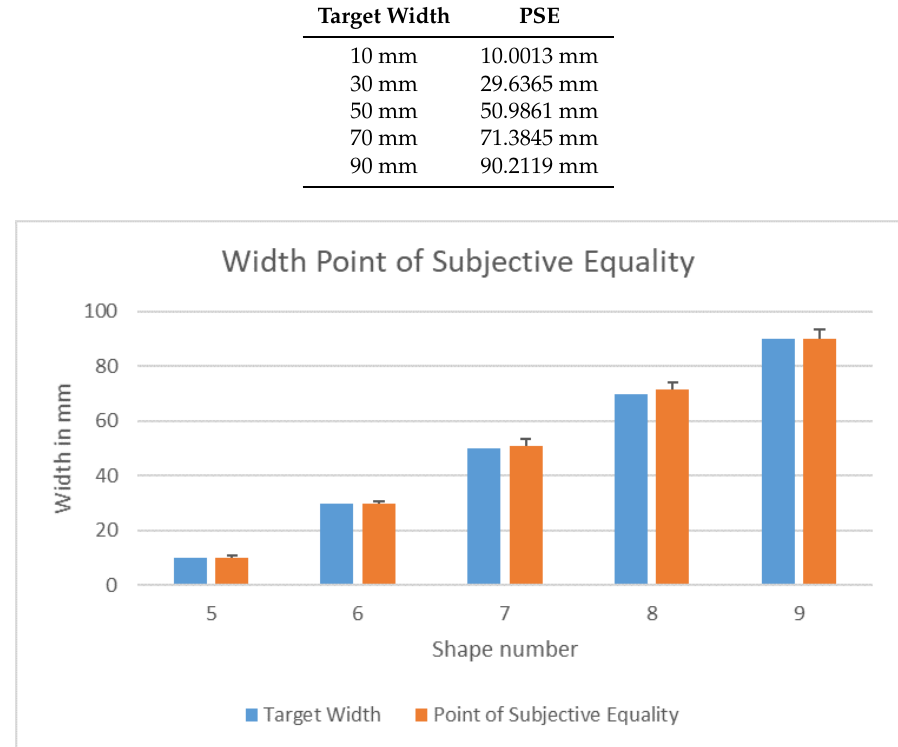
Figure 8. Mean widths adjustments in